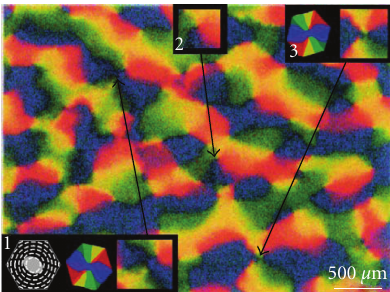
Figure 1: Color encoding of a “hypercolumn” (inset 1) and in- terpretation of an optical imaging picture from [5]. Both, “hyper- columns” (1,3) and “pinwheels” (2) can be found (arrows point to examples). A detailed analysis of such pictures is compatible with the assumption that the number of pinwheels is twice the number of hypercolumns and that the distance between hypercolumn cen- ters corresponds to the distance between blob